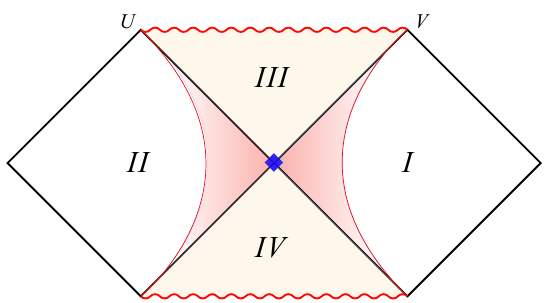
Figure 2 . The various regions, depicted on the extended Penrose diagram. In the white region the Regge-Wheeler potential dominates, while in the pink region the near-horizon gravitational interactions mediated by soft gravitons take over. The blue region is at a Planckian distance from the horizon, where the non-commutative structure of the backreaction algebra (E.3) would become important, resulting in a highly dense chaotic discrete spectrum of states eq. (E.5). In this work we do not analyse any such Planckian